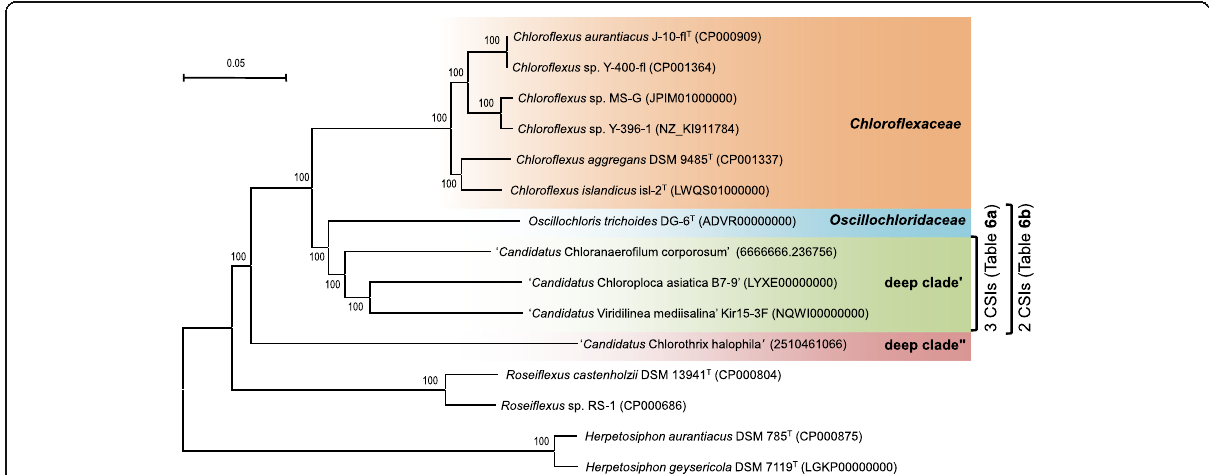
Fig. 2 Neighbor-joining phylogenetic tree inferred from the concatenated amino acid sequences of the core proteins showing the phylogeny of the representatives of the Chloroflexineae suborder. A total of 52,793 positions in the final dataset were analyzed. The bootstrap values obtained with the neighbor-joining methods are based on 1000 replicates. The scale bars represent a 5% amino acid sequence divergence. The accession number for ‘ Ca . Chloranaerofilum corporosum ’ corresponds to RAST, and the accession number for ‘ Ca . Chlorothrix halophila ’ corresponds to